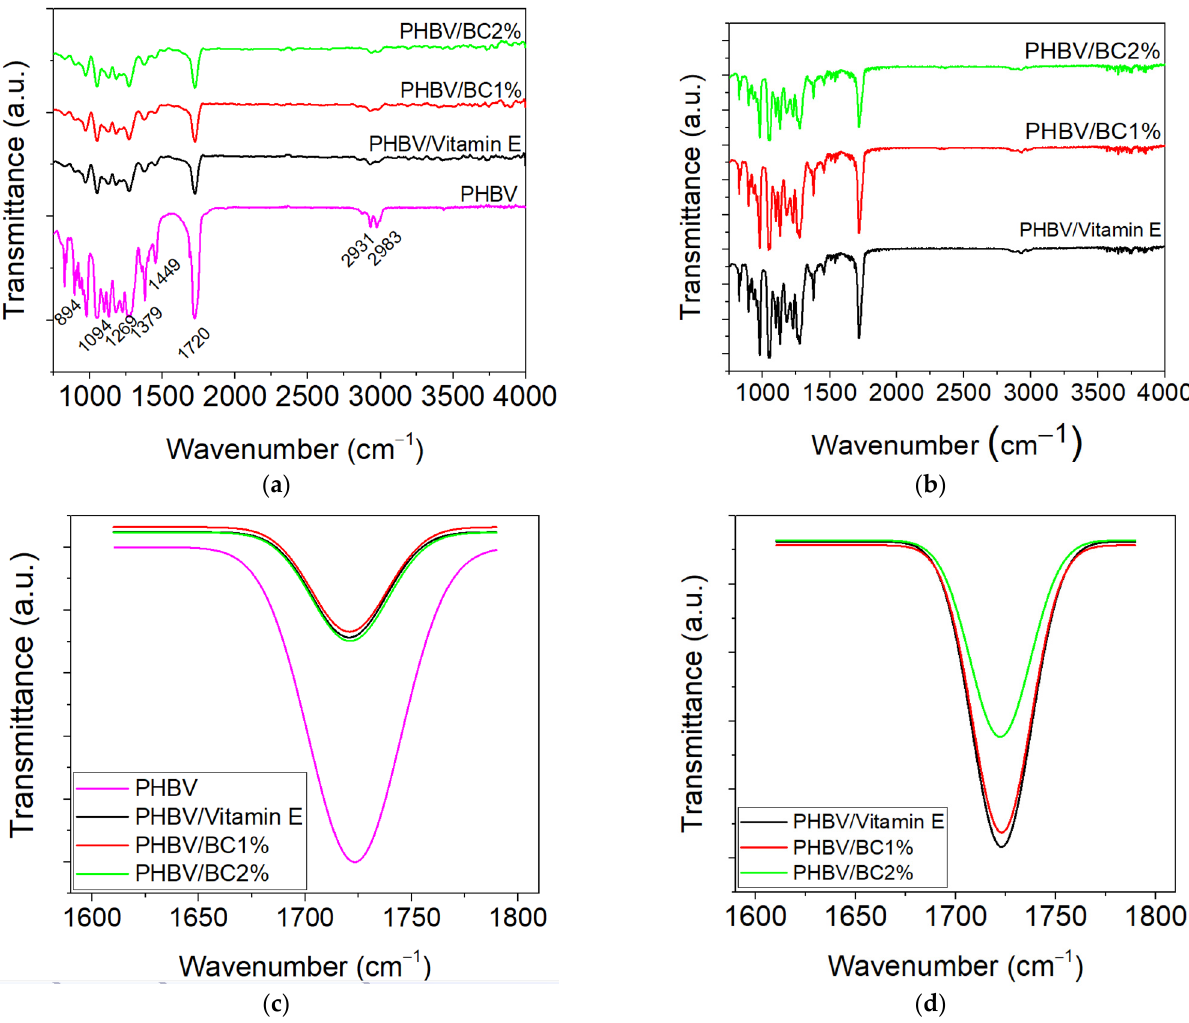
Figure 4. ATR-FTIR normalized spectra for biocomposites based on PHBV, BC and vitamin E. ( a ) initial; ( b ) after 30 days immersion in PBS; ( c ) carbonyl stretching region (–C=O) for initial samples; ( d ) carbonyl stretching region (–C=O) for degraded samples in PBS.